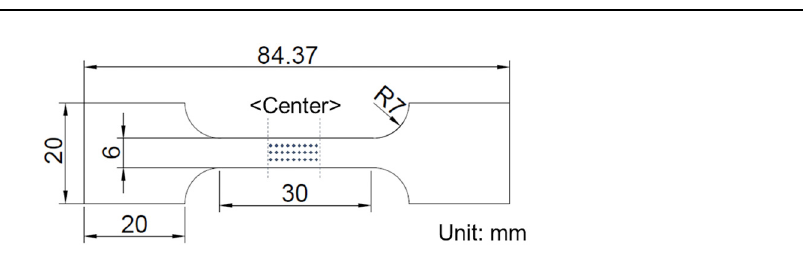
Figure 1. Schematic drawing of the experimental specimen where the longer length is parallel to the rolling direction of the as-received sheet. Table 1. Chemical composition of Al 7075 alloy (wt. %).